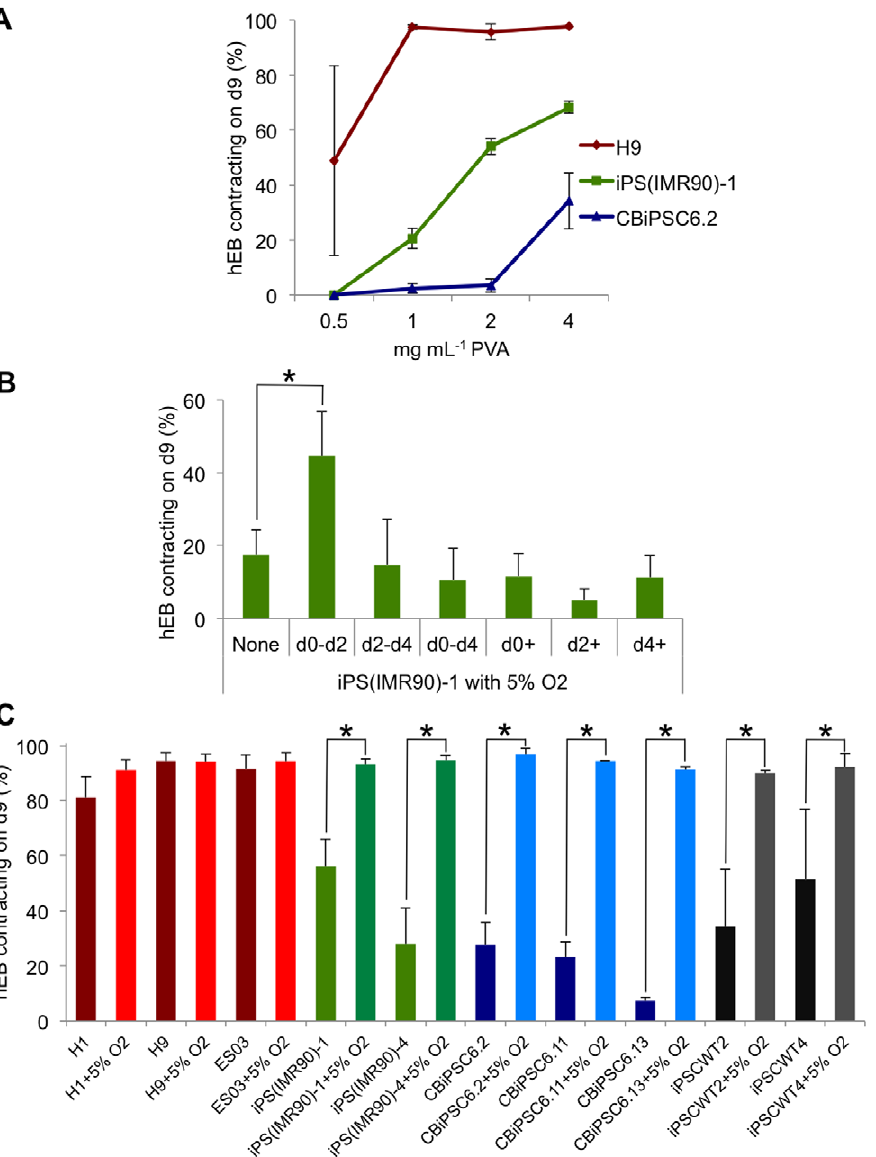
Figure 4. PVA supplementation and staged exposure to physiological oxygen eliminates interline variability of cardiac differentiation. ( A ) Increasing the concentration of PVA from 1 mg mL 2 1 to 4 mg mL 2 1 PVA in the d0–d2 media formulation enhanced the differentiation of viral fibroblast-derived hiPSC line iPS(IMR90)-1, and non-viral cord blood-derived hiPSC line CB-iPSC6.2, whilst not affecting H9 hESC ( n =3). ( B ) Exposure of iPS(IMR90)-1 hEB to physiological (5%) oxygen tensions from differentiation d0–d2 also enhanced cardiac differentiation ( n =3, p , 0.005). Identical conditions did not improve already highly efficient H9 hESC differentiation. ( C ) Combining both physiological oxygen tension and 4 mg mL 2 1 PVA between d0–d2 eliminated interline differentiation variability in hiPSC derived using both viral- and non-viral-techniques ( n $ 3, p , 0.005). Error bars, 6 S.E.M.